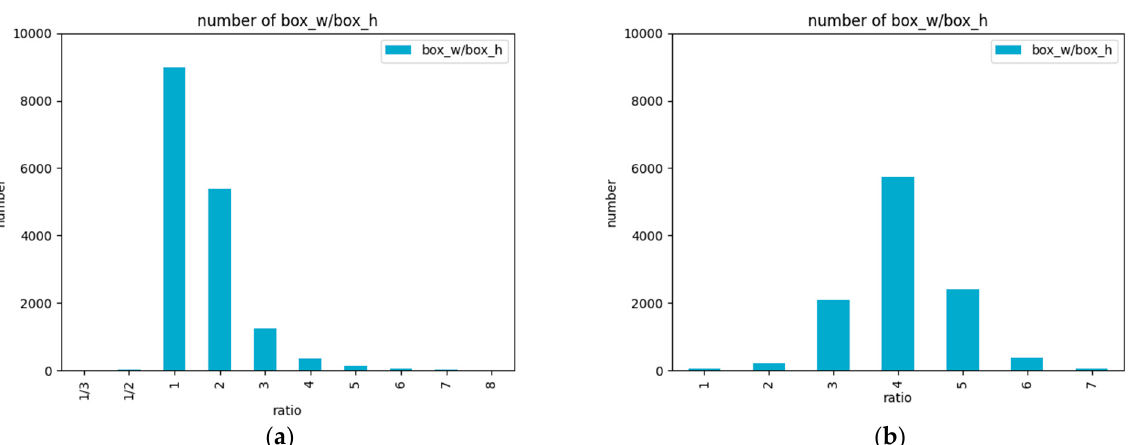
Figure 7. The number of aspect ratios of the ground truth bounding boxes. ( a ) The number of aspect ratios for vehicles; ( b ) The number of aspect ratios for license plates.